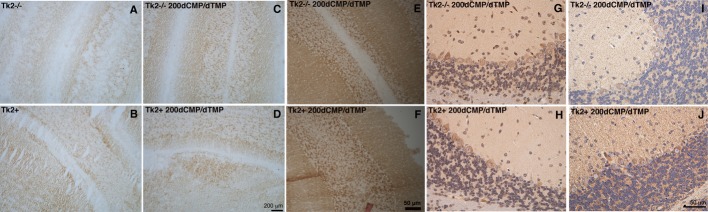
Complex I immunohistochemistry and complex IV histochemistry of cerebellumA–D   Complex IV (COX) histochemistry of cerebellum showing deficiency in 13-day-old untreated Tk2−/− (A) in contrast to normal COX activity in Tk2+ (B), Tk2−/−200dCMP/dTMP (C), and Tk2+200dCMP/dTMP (D) mice.E–H   COX histochemistry (E-F) and immunostaining against COX subunit II (G-H) of cerebellum showed no differences between 29-day-old Tk2−/−200dCMP/dTMP (upper panels) and age-matched Tk2+200dCMP/dTMP mice (lower panels).I–J   Anti-complex I NDUFB8 subunit immunostaining of brain showed reduced staining in 29-day-old Tk2−/−200dCMP/dTMP (I) versus Tk2+200dCMP/dTMP mice (J).